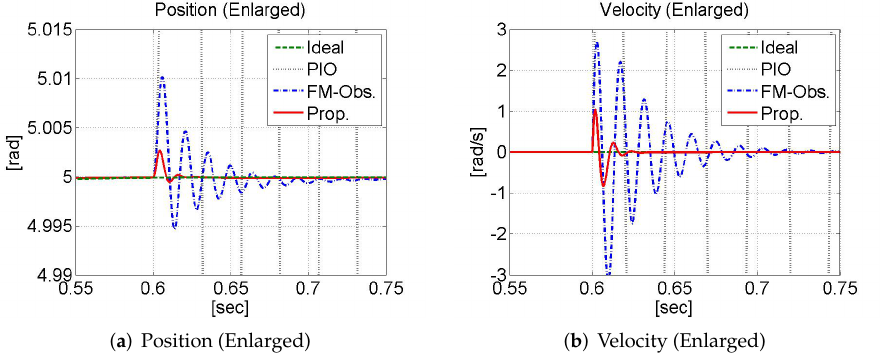
Figure 5. Results of DC motor velocity.